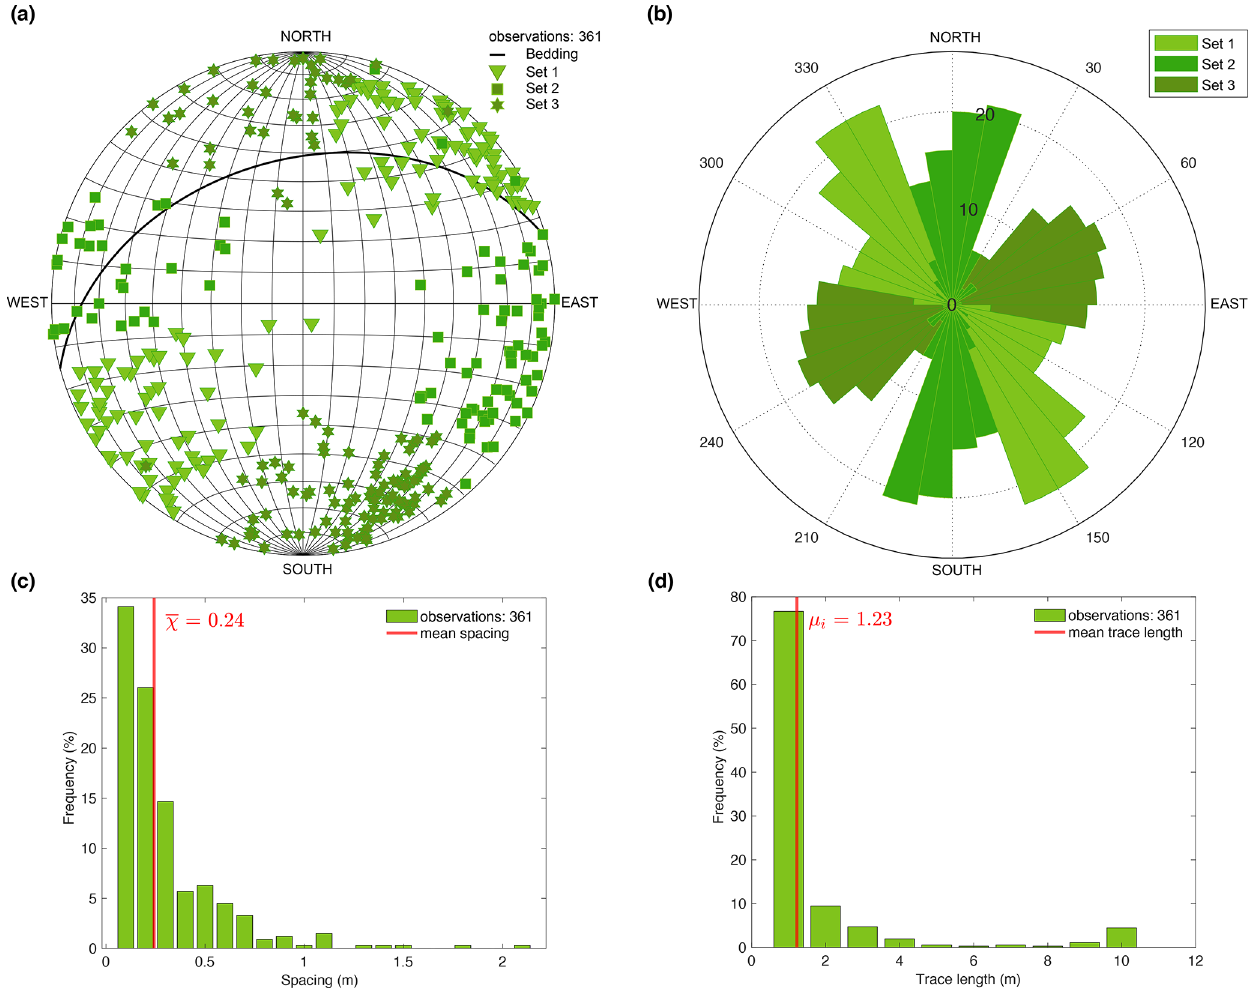
Figure 5. Results of all scanline investigations at the quarry in Hagen-Hohenlimburg: (a) stereogram of measured discontinuity sets and a (b) rose diagram of rotated discontinuity orientations according to the bedding layer in panel (a) for a horizontal position, (c) discontinuity spacing diagram, and (d) discontinuity trace length